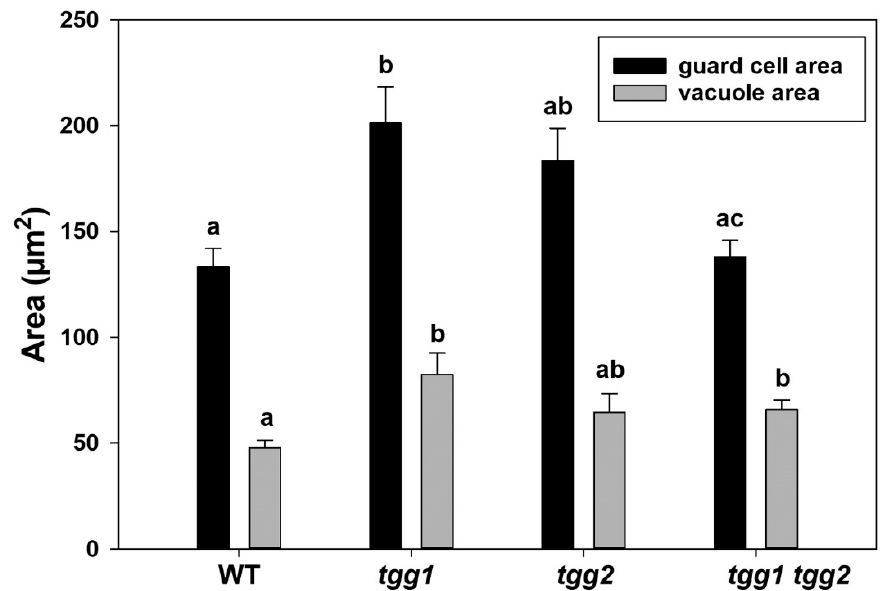
Figure 6. Area of GCs and vacuoles from transmission electron micrographs of rosette leaves of WT, tgg1 , tgg2 single, and tgg1 tgg2 double mutants of Arabidopsis . Bars represent the means ± SE (WT: n = 12), ( tgg1: n = 15), ( tgg2: n = 15), and tgg1 tgg2 ( n = 18). Different letters (a, b and c) above the bars indicate significant differences in guard cell area and vacuole area between WT, tgg1 , tgg2 , and tgg1 tgg2 as determined by a Kruskal-Wallis test followed by a Dunn’s method for pairwise comparisons ( p < 0.05).